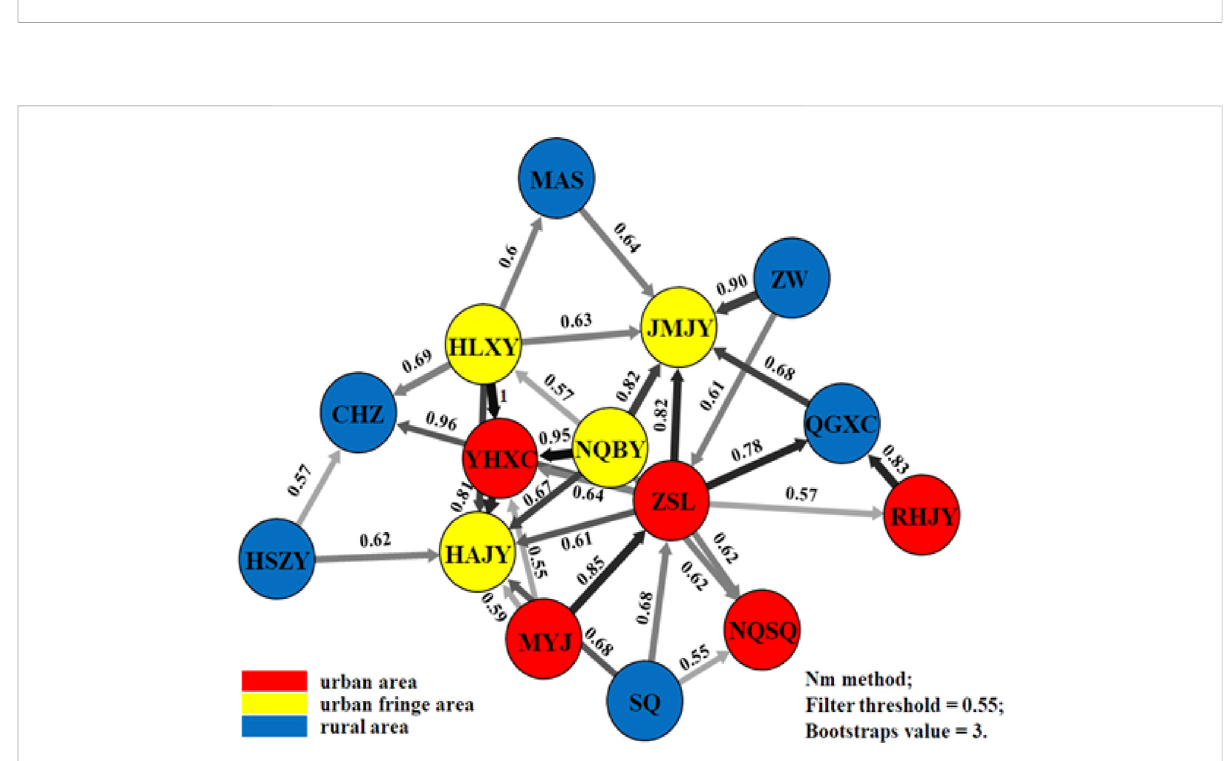
FIGURE 5 Migration patterns of Ae. albopictus among urban, urban fringe, and rural areas of Nanjing